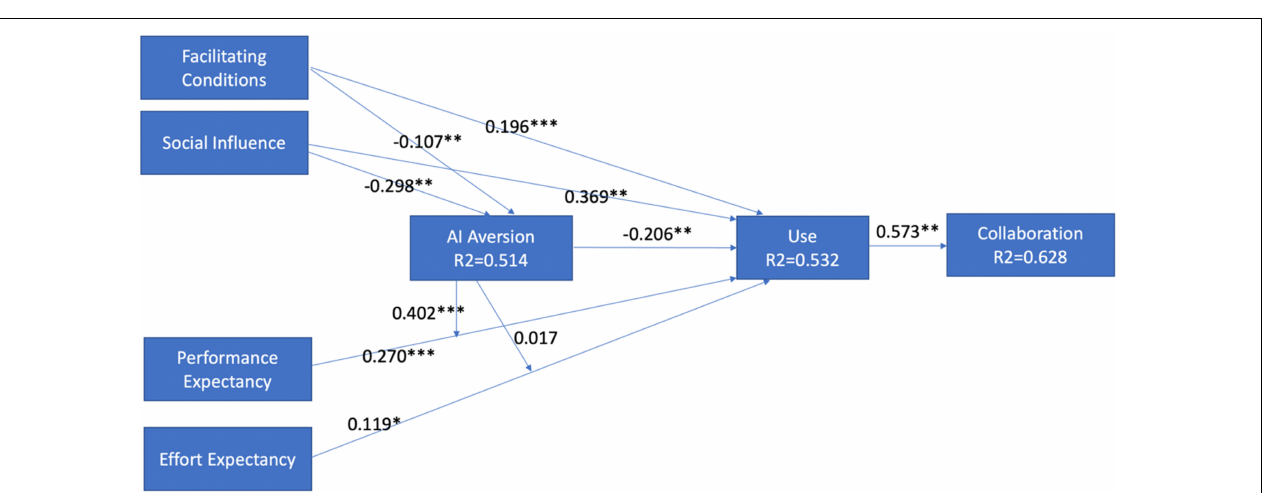
FIGURE 2 | Final model. Source: primary data, ∗∗∗ p < 0.001, ∗∗ p < 0.01, ∗ p <